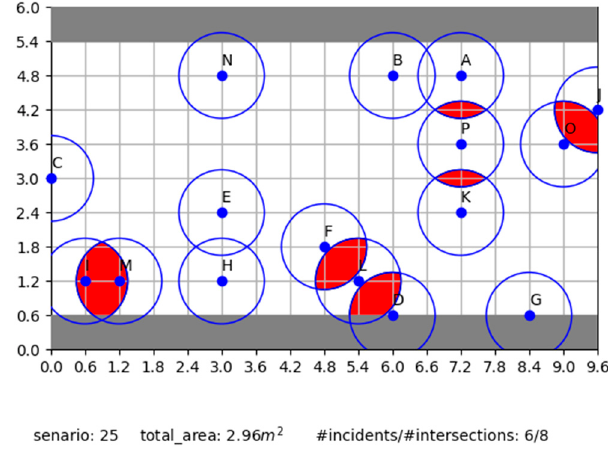
Figure 2. The graphic output sample.